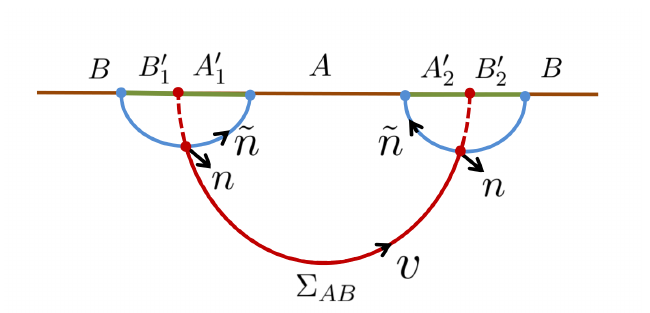
Figure 8: The blue lines are the RT surfaces E while the red curve is the EWCS Σ AB which is normal to E . Though the figure looks static, we should consider it to be a AB covariant configuration.